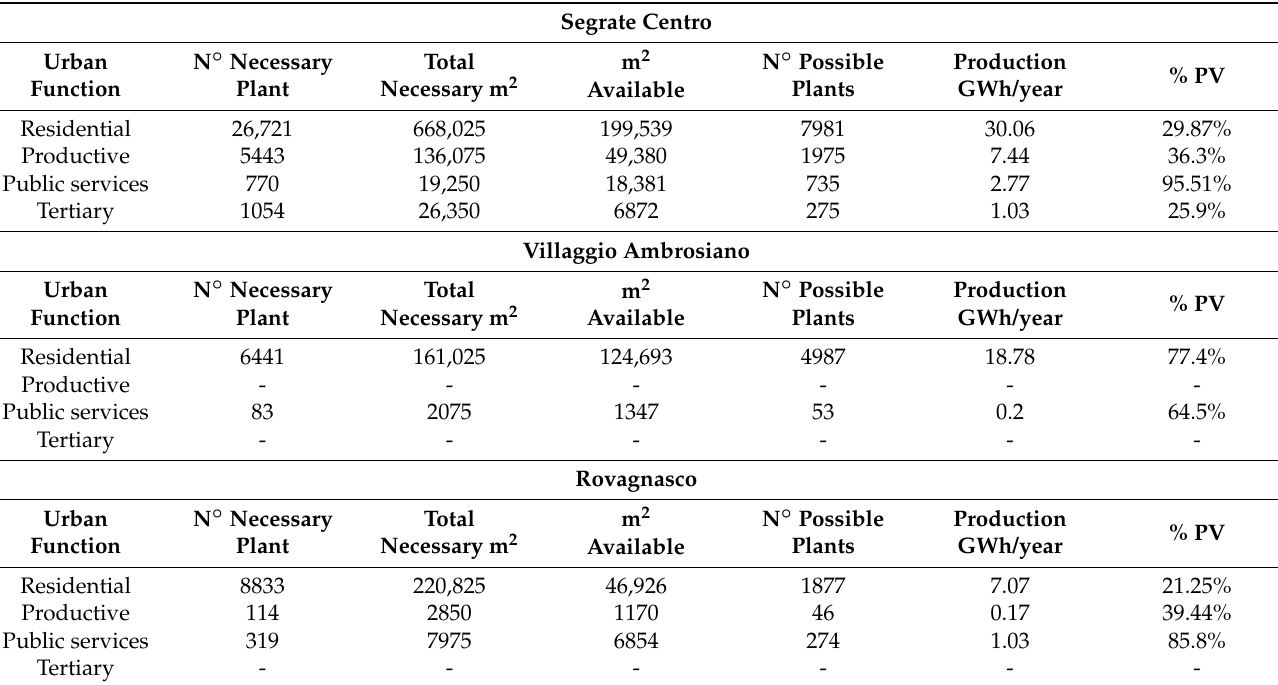
Table 4. PV plant necessary and PV plant really placeable in the case study’s